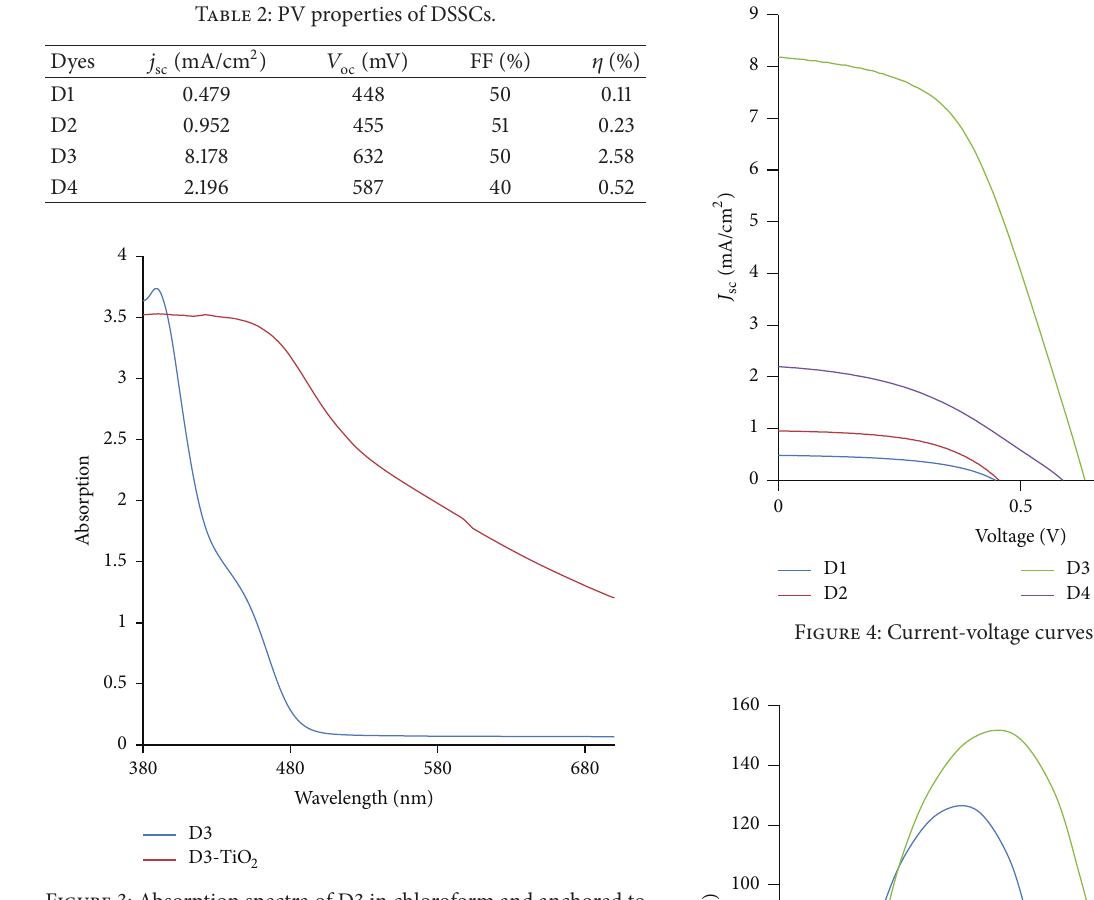
Figure 3: Absorption spectra of D3 in chloroform and anchored to TiO 2 .